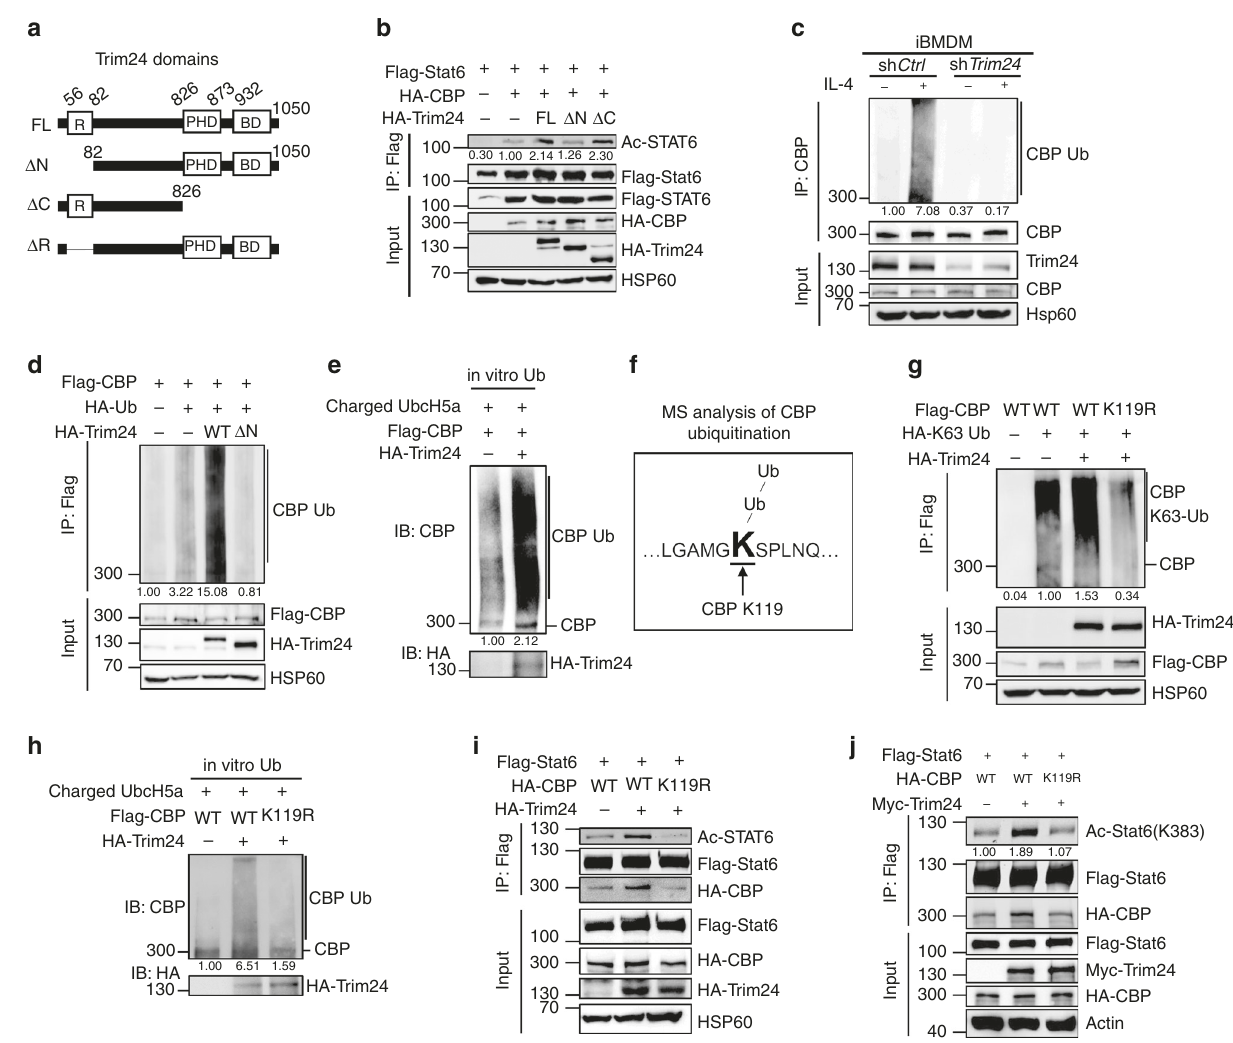
Fig. 4 Trim24-mediated Lys63-linked ubiquitination of CBP at Lys119. a Structure schematic of full-length (FL) Trim24 and its truncations. b Immunoblot analysis of the lysine acetylation of Stat6 in 293T cells transfected with the indicated expression vectors assessed by immunoprecipitation (IP) with anti- Flag and immunoblotting with anti-Ac-Lys and anti-Flag; lysates were immunoblotted to detect input proteins and loading controls. c Endogenous ubiquitination of CBP in control and Trim24- knockdown iBMDMs that were unstimulated ( − ) or stimulated ( + ) with IL-4 for 30 min assessed by immunoblot analysis with anti-ubiquitin after immunoprecipitation with anti-CBP (top) and immunoblot analysis with input proteins and loading controls (below). d Ubiquitination of CBP in 293T cells transfected with the indicated expression vectors assessed by immunoblot analysis with anti-HA after immunoprecipitation with anti-Flag (top) or immunoblot analysis with input proteins in lysates without immunoprecipitation (below). e In vitro ubiquitination assay to determine CBP ubiquitination after a mixture reaction of ubiquitin-charged E2 (UbcH5a) and in vitro-translated Flag-CBP with or without HA-Trim24 proteins was assessed by immunoblot analysis with anti-CBP and anti-HA. f Mass spectrometry analysis of the CBP ubiquitination site after the immunoprecipitation of overexpressed Flag-CBP in 293T cells transfected with Flag-CBP and HA-Trim24 showing that Lys119 is the site of CBP ubiquitination by Trim24. g Ubiquitination of CBP in 293T cells transfected with the indicated expression vectors assessed by immunoblot analysis with anti-HA after immunoprecipitation with anti-Flag (top) or immunoblot analysis with input proteins in lysates without immunoprecipitation (below). h In vitro ubiquitination assay to determine CBP ubiquitination after a mixture reaction of ubiquitin-charged E2 (UbcH5a) and in vitro-translated wild-type (WT) or the K119R mutant Flag-CBP with or without HA-Trim24 proteins was assessed by immunoblot analysis with anti-CBP and anti-HA. i , j Immunoblot analysis of the lysine acetylation of Stat6 and the interaction of wild-type (WT) or the K119R mutant CBP with Stat6 in 293T cells transfected with the indicated expression vectors, assessed by immunoprecipitation with anti-Flag and immunoblot with anti-Ac-Lys, anti-Ac-Stat6 (K383), anti-HA, and anti- Flag. Each panel is a representative experiment of at least three independent biological replicates. Source data are provided as a Source Data fi